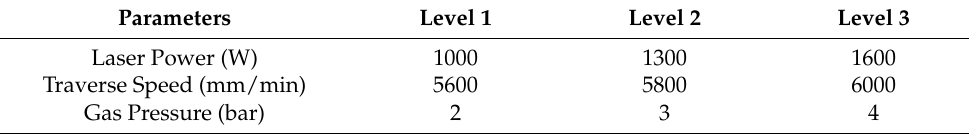
Table 2. Input parameters levels for specimen thickness of 4 mm, in laser beam cutting